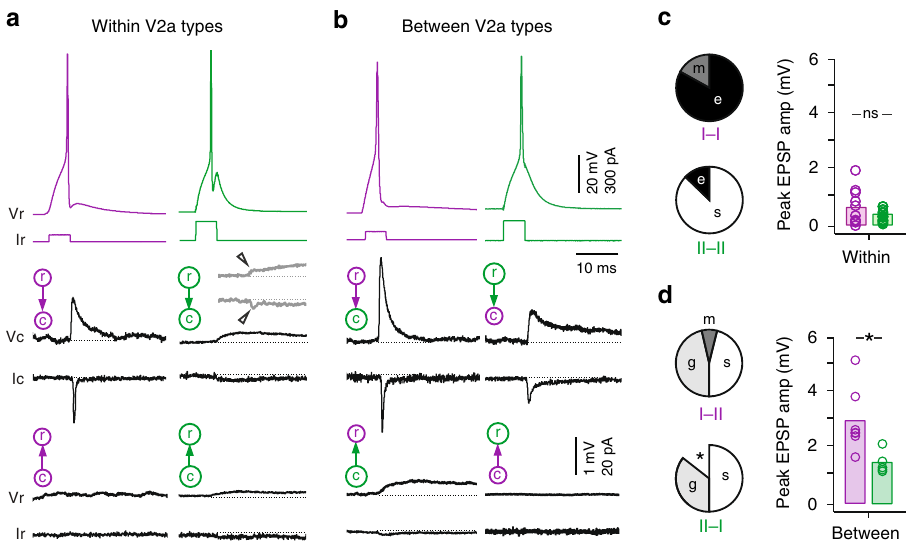
Fig. 3 Distinct patterns of connectivity within and between V2a types. a Left, example of paired recording within type I V2a neurons (purple) testing connectivity in the descending (top and middle traces) and ascending directions (bottom traces), as indicated by cartoons (r rostral, c caudal). Right, example of a paired recording within type II V2a neurons (green). For simplicity, spikes evoked in caudal neurons are not illustrated. Spikes are individual sweeps, while post-synaptic responses are spike triggered averages of all events. I, current; V, voltage. Inset gray trace is from another paired type II V2a neuron recording on the same scale, illustrating the weak descending electrical synapse (at arrowheads). b As in panel a , but paired recordings between type I and II V2a neurons. Middle traces are averages of successful events. c Left, quanti fi cation of the mode of descending synaptic connectivity within different types of V2a neurons expressed as a percentage of total recordings (I to I, n = 12; II to II, n = 15). e electric, m mixed, s slow. Right, quanti fi cation of the peak amplitudes of EPSPs (electric, mixed, glutamatergic or slow) measured within type I (purple, n = 12) and type II (green, n = 15) V2a neurons. ns, not signi fi cant following Mann – Whitney U -test, U(25) = 105, p = 0.464. Bars represent means. Source data are provided in a Source Data fi le. d Left, quanti fi cation of the mode of descending synaptic connectivity between types expressed as a percentage of total recordings (I to II, n = 13; II to I, n = 14). Asterisk marks proportion of total recordings where no connection was observed ( n = 2). g glutamatergic. Right, quanti fi cation of the peak amplitudes of glutamatergic EPSPs measured from type I to II V2as (purple, n = 7) and from type II to type I V2as (green, n = 5). * signi fi cant difference following Mann – Whitney U -test, U(10) = 34, p < 0.01. Source data are provided in a Source Data fi